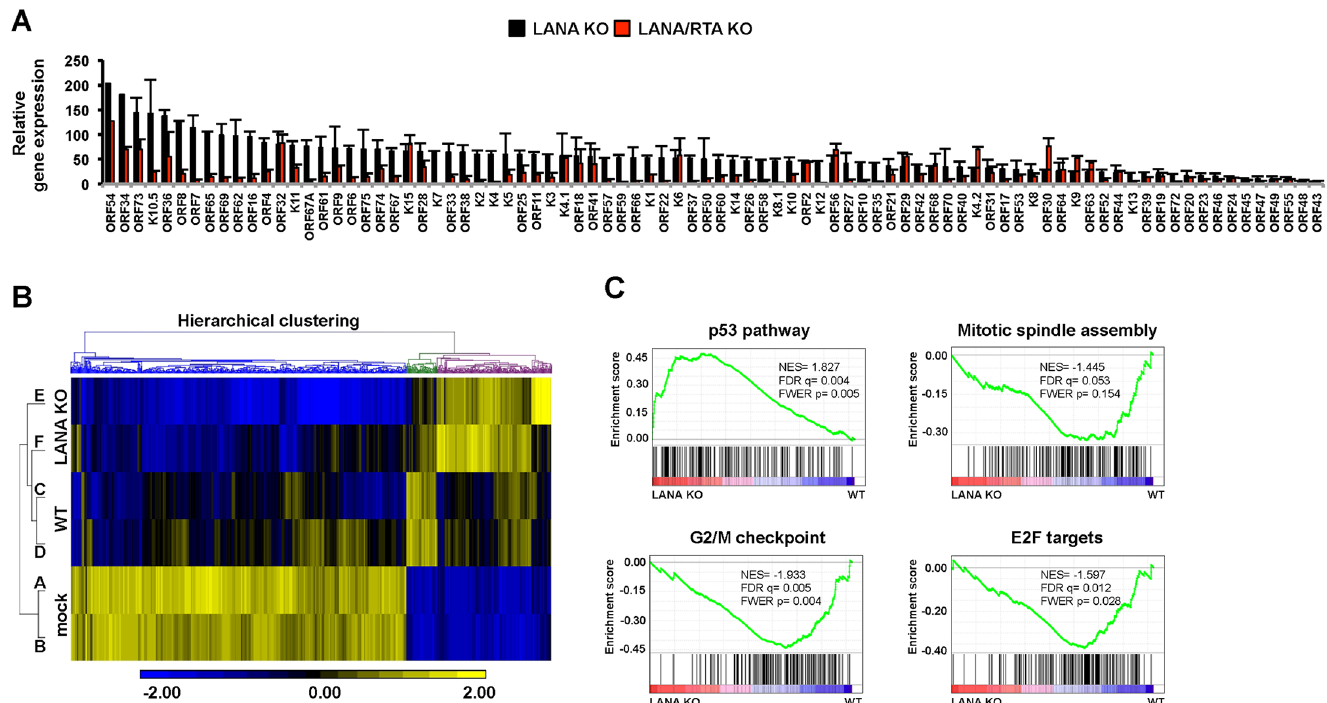
Fig 3. Deregulated viral and cellular gene expression in LANA KO KSHV-infected cells. (A) Analysis of viral gene expression in LANA KO and LANA/RTA KO KSHV-infected cells compared to WT KSHV-infected cells by NanoString technology. (B) Heat map of differential gene expression between mock and KSHV-infected cells. Rows A and B, C and D, E and F represent two biological replicates of mock-, WT, and LANA KO KSHV-infected SLK cells, respectively. Also see S3 Table. (C) Biological pathways significantly affected by the lack of LANA in KSHV-infected cells were determined by gene set enrichment analysis. Also see S4